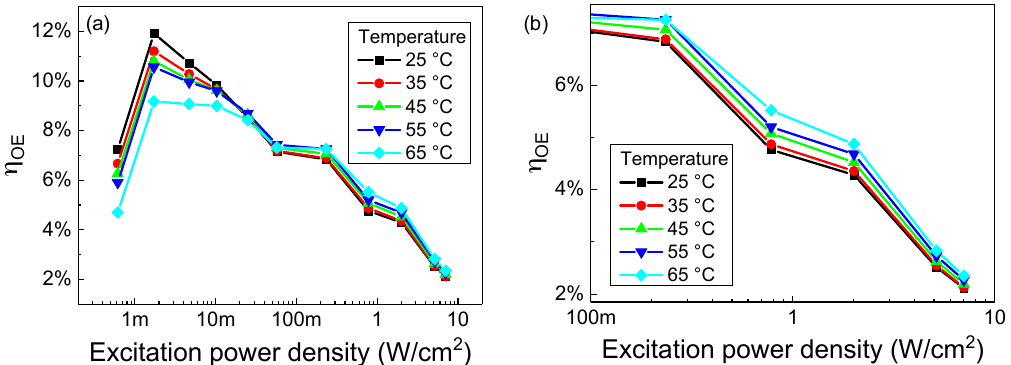
Figure 5. ( a ) Optical to electrical conversion efficiency of the designed laser-based wireless power transfer system as a function of the excitation power density at various receiver operating temperatures; The high-energy region is zoomed in ( b ).